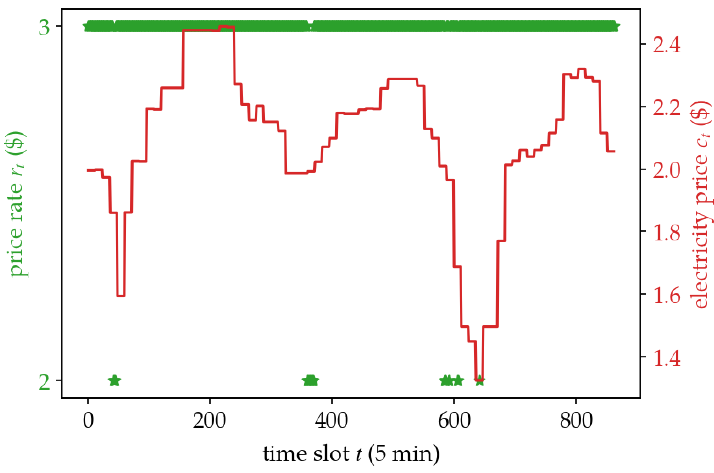
Figure 19. Price announced to customers vs. electricity price paid to utility company (three-day episode duration).